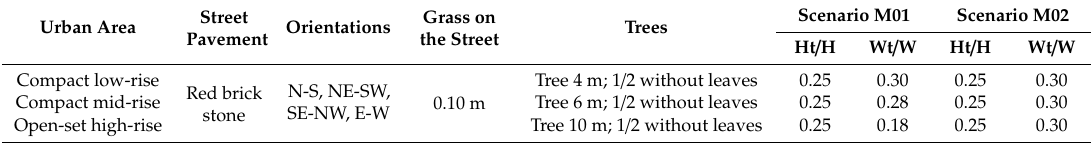
Table 10. Settings of the scenarios M01 and M02 to study the e ff ect of the vegetation elements. Urban Area Compact